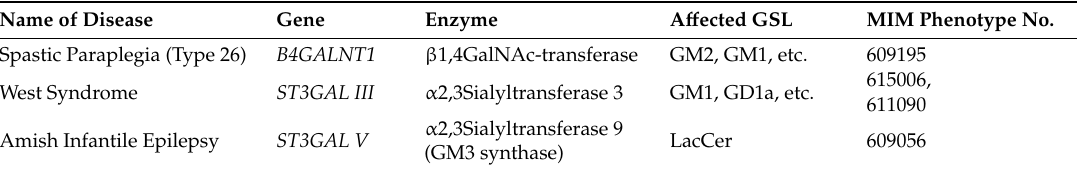
Table 2. Disorders of glycosphingolipid